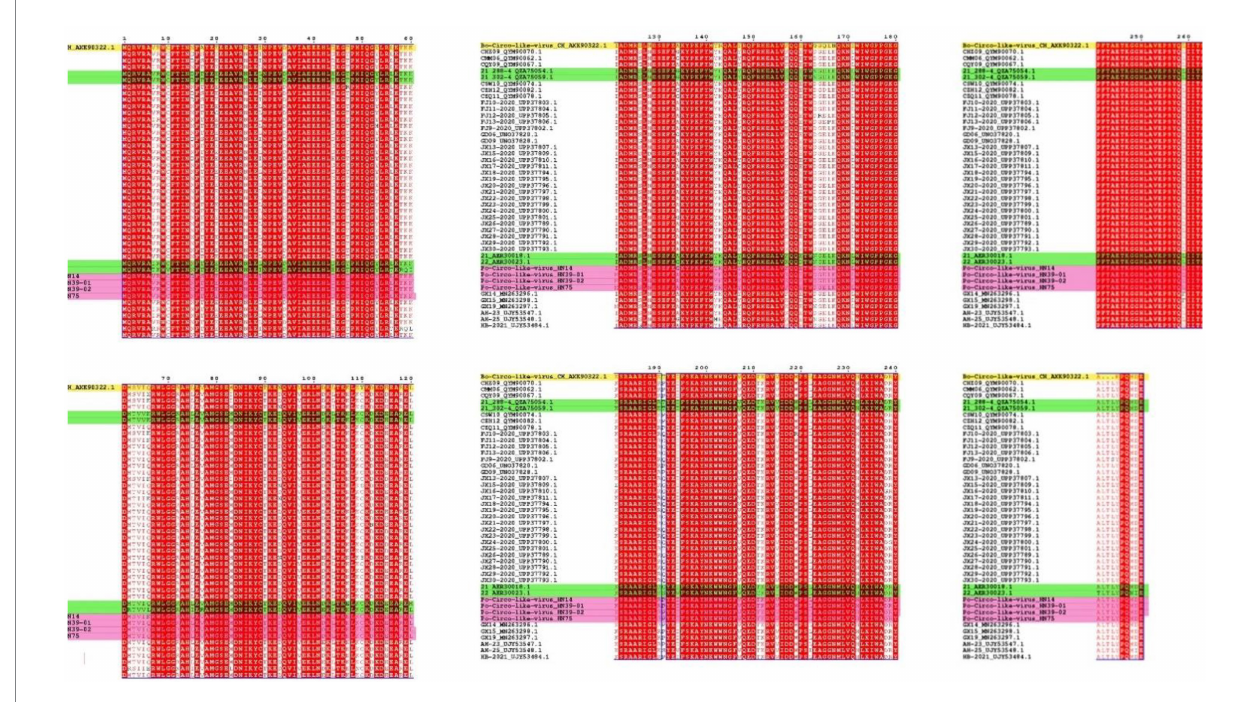
FIGURE 3 Amino acid comparison and analysis on Rep protein. The strains in this study are marked in pink. Yellow indicates the Bo-Circo-like virus, and unlabeled strains indicate of other Po-Circo-like virus detected in China. Green marks the four strains of the Po-Circo-like virus found in the United